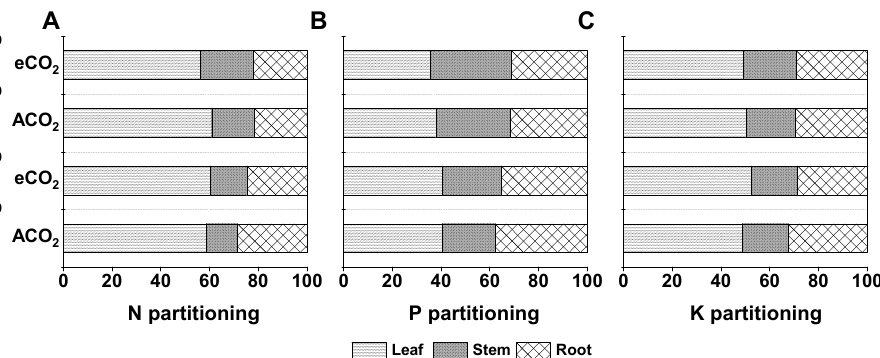
Figure 5. Leaf, stem and root nitrogen (N), ( A ), phosphorus (P), ( B ) and potassium (K), ( C ) partitioning in two mulberry varieties ( Morus multicaulis Perr. var. QiangSang and NongSang) grown under ambient CO 2 (ACO 2 , 410/460 ppm, daytime/nighttime) and elevated CO 2 (eCO 2 , 710/760 ppm) levels.